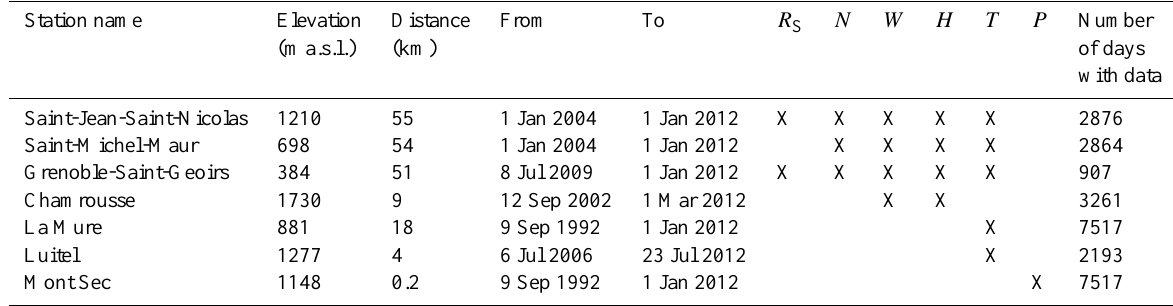
Table 1. Summary of weather data sets with parameters used (X) at the various locations. Distance is measured from the Séchilienne landslide, R S is the solar radiation, N is the sunshine duration, W is the wind speed, H is the humidity, T is the temperature and P is the precipitation depth.